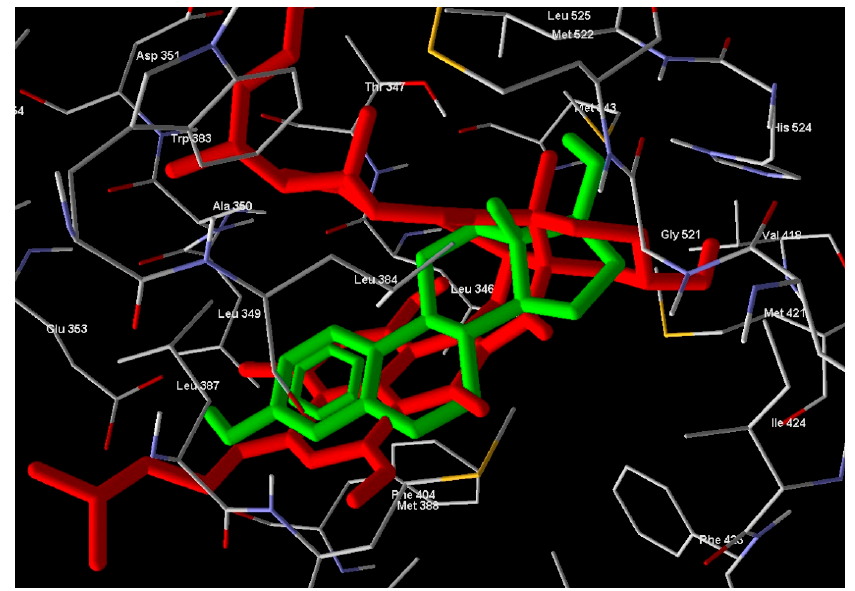
Figure 5. Compound 1 (red molecule) superimposed with standard drug (green molecule) in ER α -LBD active site (Color figure